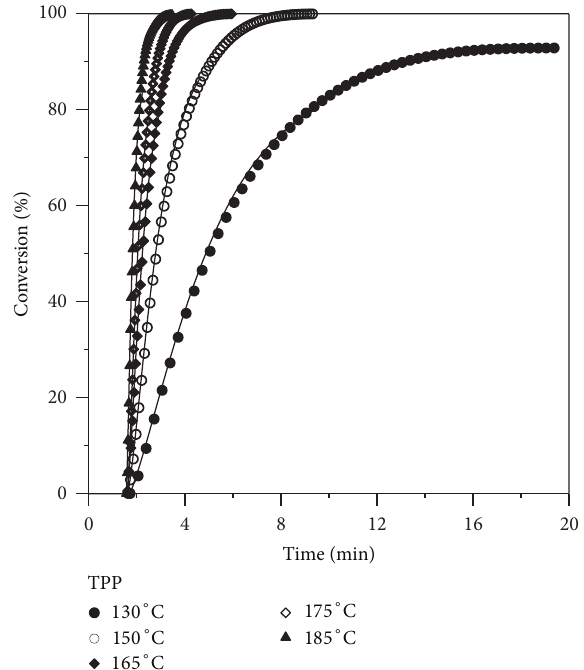
Figure 6: Comparison between the autocatalytic model and data for TPP-cured EMCs at isothermal temperatures.